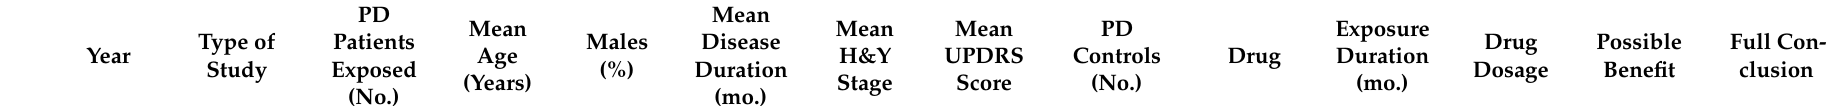
Table 2. Disease-modifying effect of antihypertensive drugs in